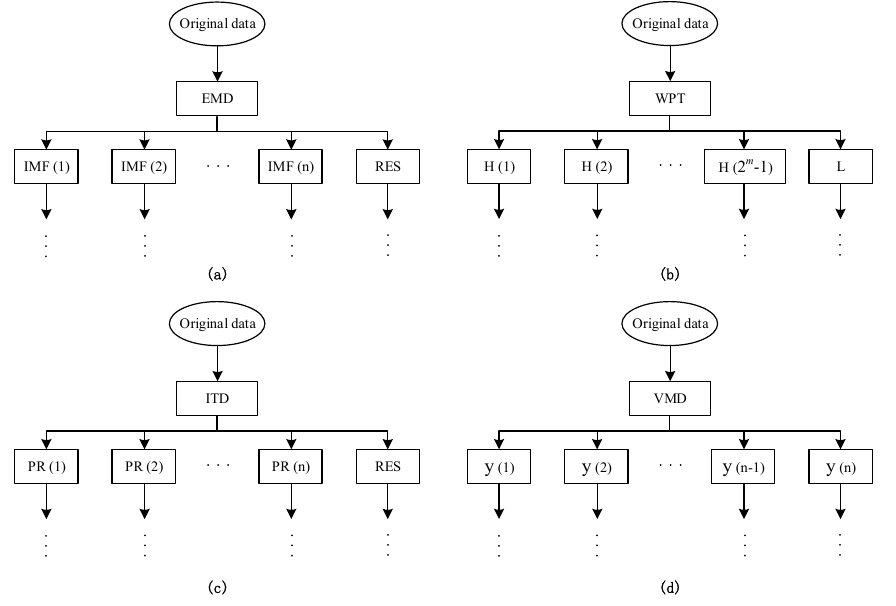
Figure 5. The process of the four decomposition methods.